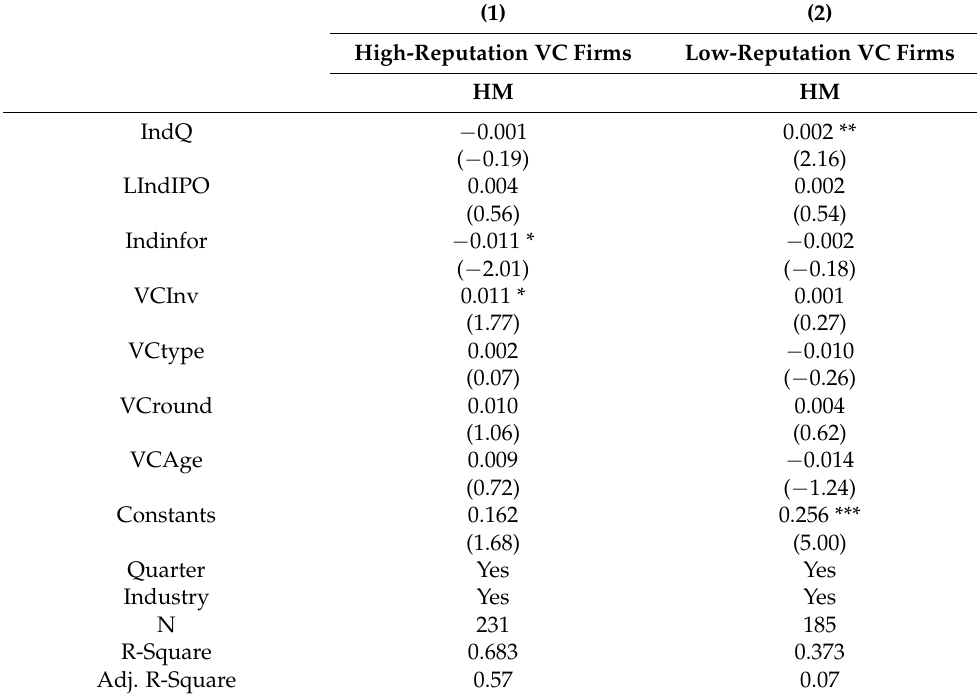
Table 6. Herding among venture capitalists: the role of VC